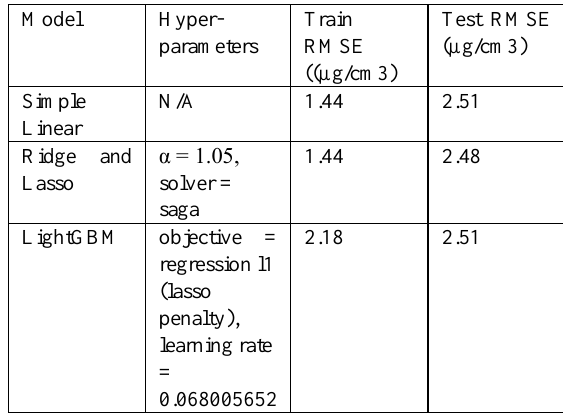
Table 1 . Results of the optimized models for predicting Chl-a. All models had similar Test RMSE, with the linear regression models overfitting to the train data causing a lower Train RMSE. Figure 4. Chl-a concentration map of Laguna Lake produced via C2RCC. Raster image taken at 09:30 on 9 October 2019. Most Chl-a is concentrated in the center of the lake, with a mode concentration of roughly 15 µg/L